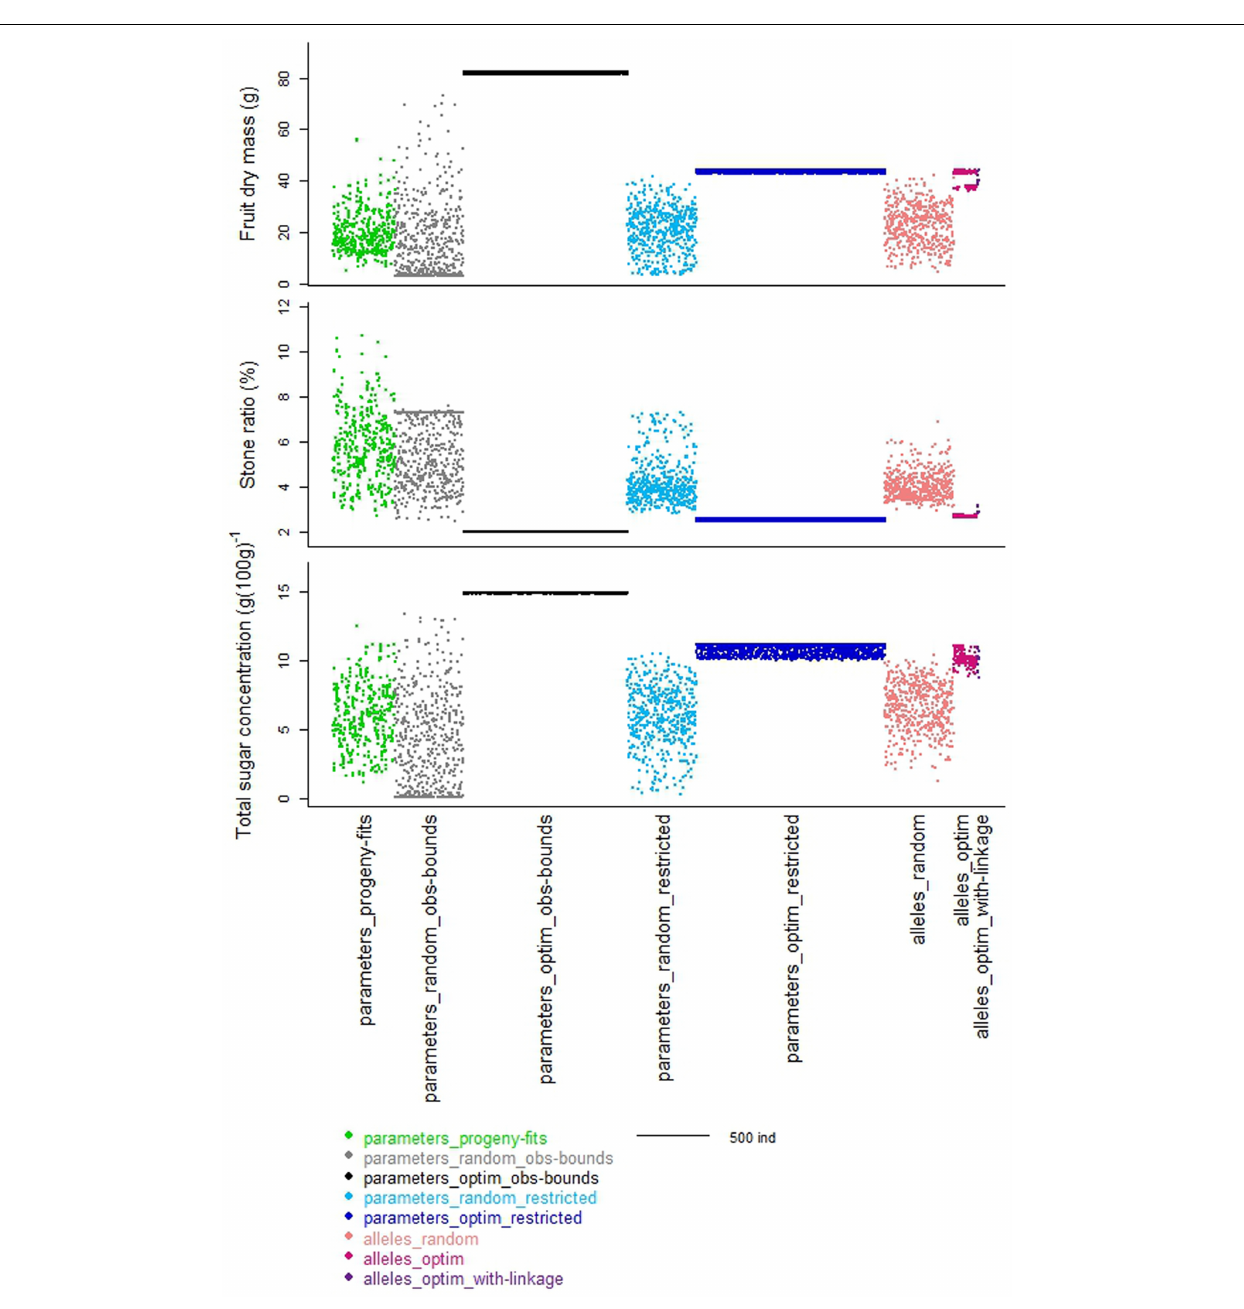
FIGURE 2 | Schematic representation of the distribution of the values of the three target traits taken by the individuals from the different datasets. Colors represent the different datasets organized along the x -axes. Width of each dataset depends on the number of individuals in the